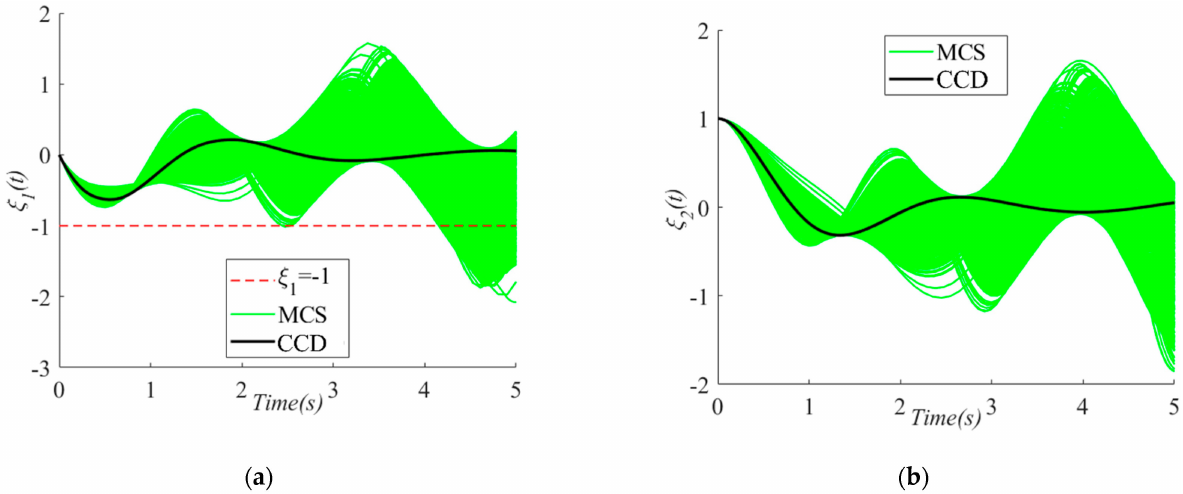
Figure 2. MCS plots of state variables in the solution of CCD: ( a ) ξ 1 ( t ) , ( b ) ξ 2 ( t )